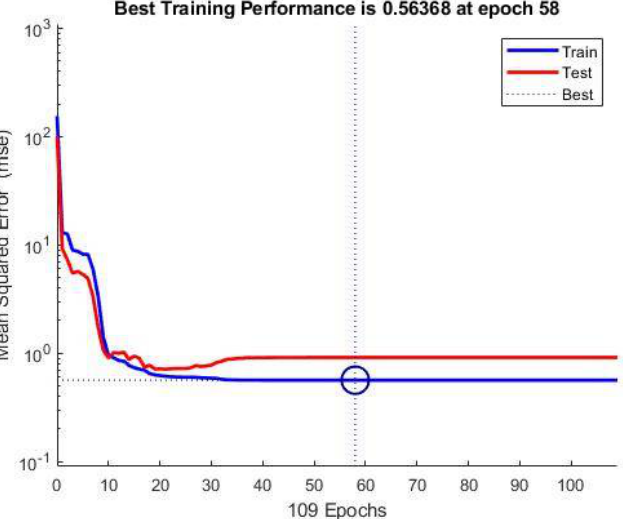
Figure 13. Performance of the BP neural network. Validation reaches best performance at epoch 58 with an MSE value equals to